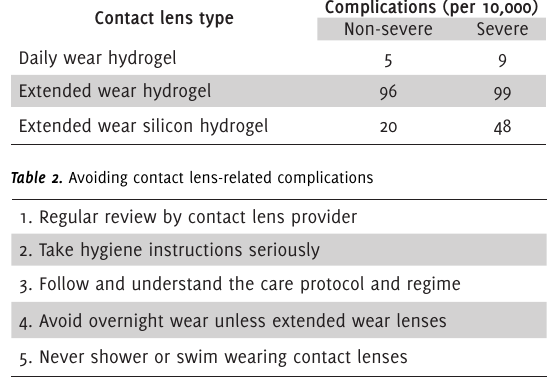
Figure 2. Relative risks and non-compliance for a range of compliance and usage factors